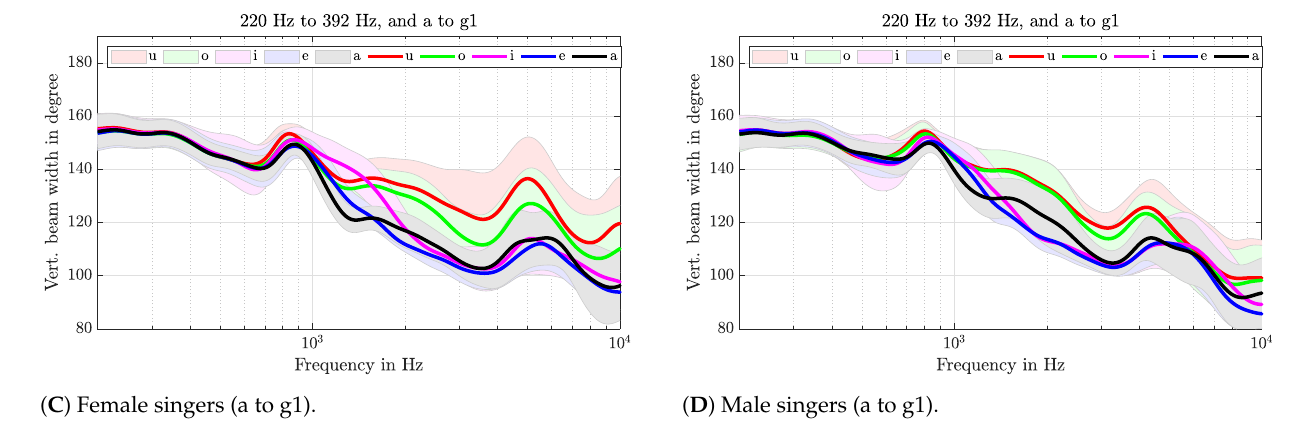
Figure A1. Mean and standard deviation for the horizontal and vertical beam width in degree aver- aged over pitch for the female singers and male singers for all five vowels and all phonation modes. Table A2. Biserial correlation coefficients for the horizontal and vertical directivity indexes at each pitch for the female singers (samples n = 18). Horizontal and vertical biserial correlation coefficients are listed at the top and bottom in each cell. Bold letters indicate that there is a significant difference ( p > 0.05) between the vowel groups listed in the first and second